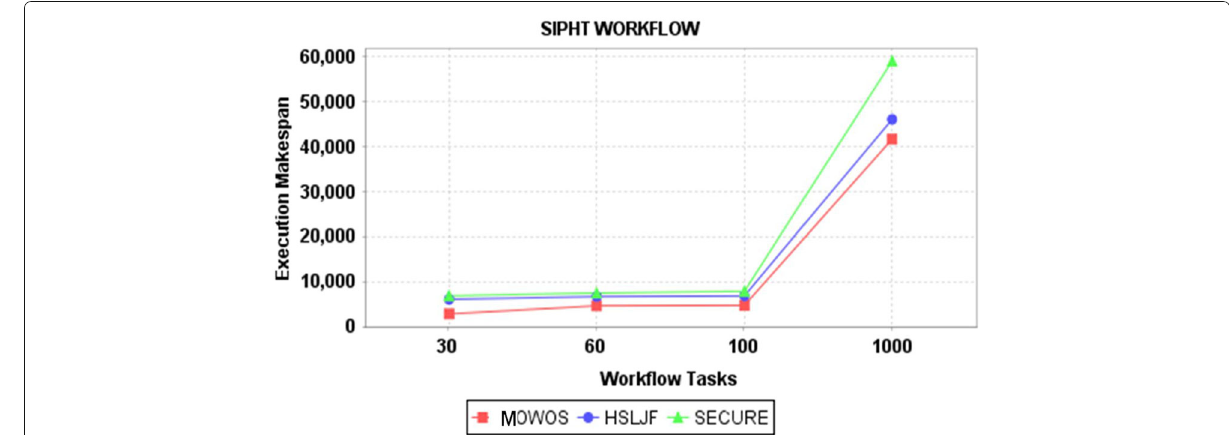
Fig. 11 Makespan results of SIPHT workflow